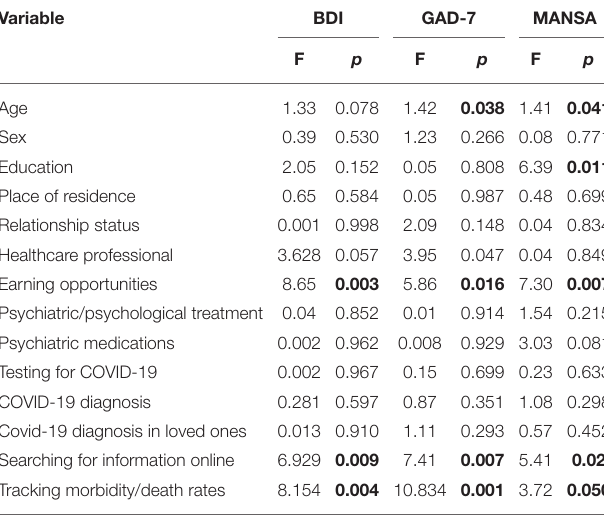
TABLE 6 | Effects of confounding factors on differences between study stages (ANCOVA). Variable